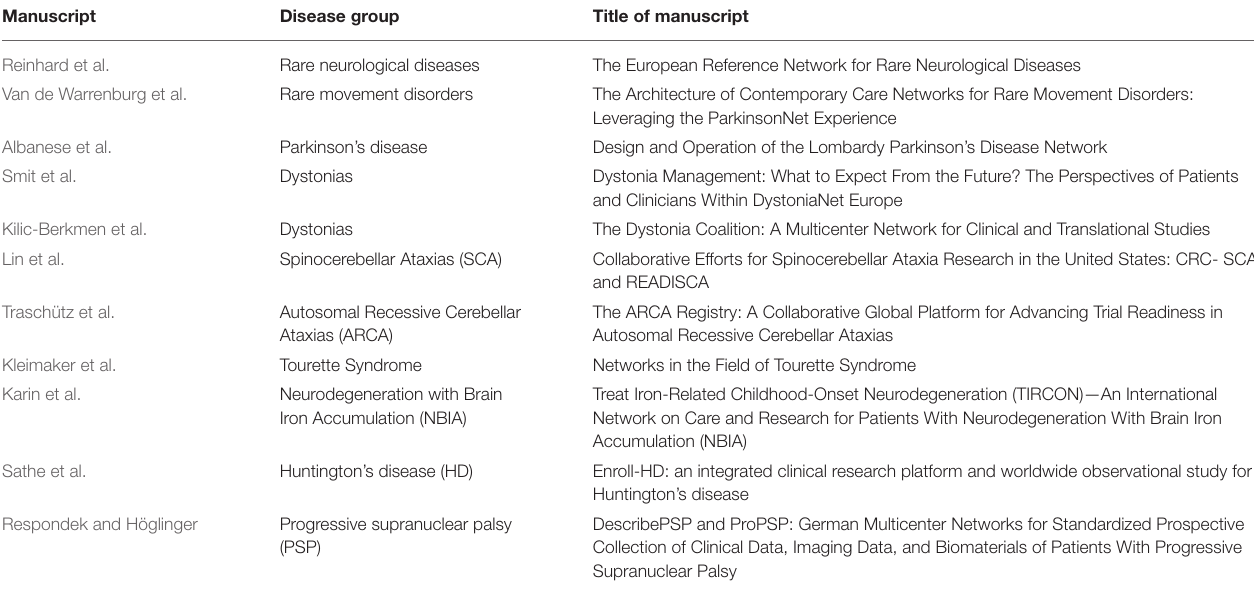
TABLE 1 | Overview of disease group focus of the Networks in Movement Disorders